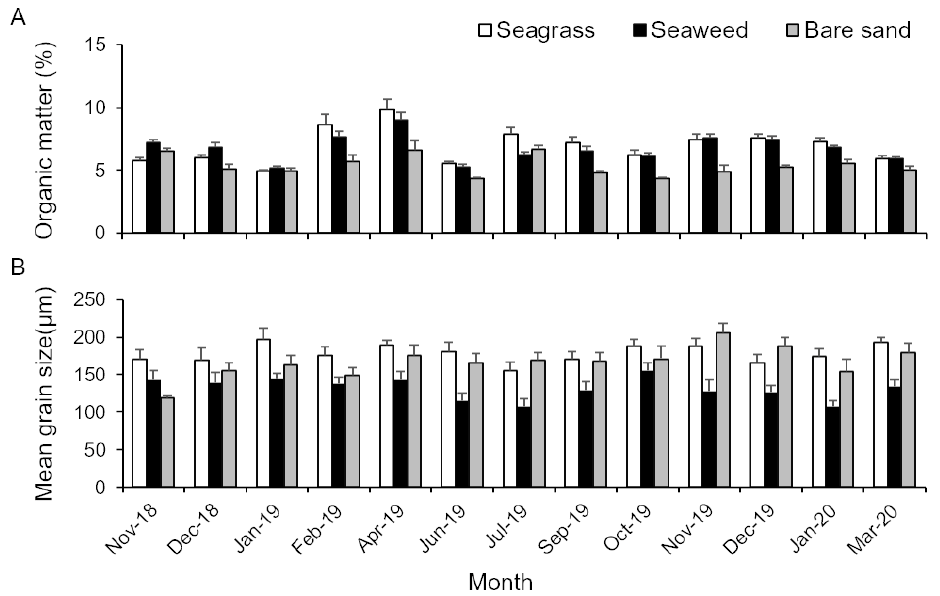
Figure 3. Properties of sediment (mean ± SE): ( A ) organic matter and ( B ) grain size in seagrass, seaweed, and bare sand habitats from November 2018 to March 2020. Table 1. Results of Scheirer ‐ Ray ‐ Hare testing of data of the effects of habitat type and month on to ‐ tal length of H. atra and sedimentary organic matter.